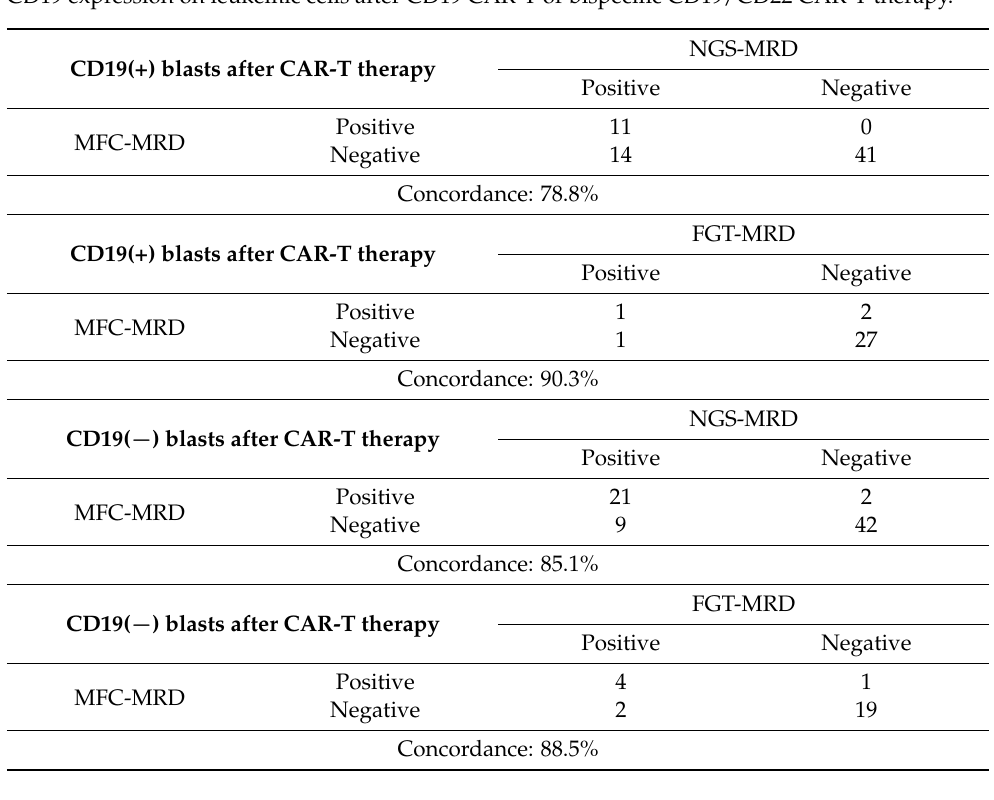
Table 4. Qualitative concordance between MFC-MRD and NGS-/FGT-MRD results according to CD19 expression on leukemic cells after CD19 CAR-T or bispecific CD19/CD22 CAR-T therapy. CD19(+) blasts after CAR-T therapy